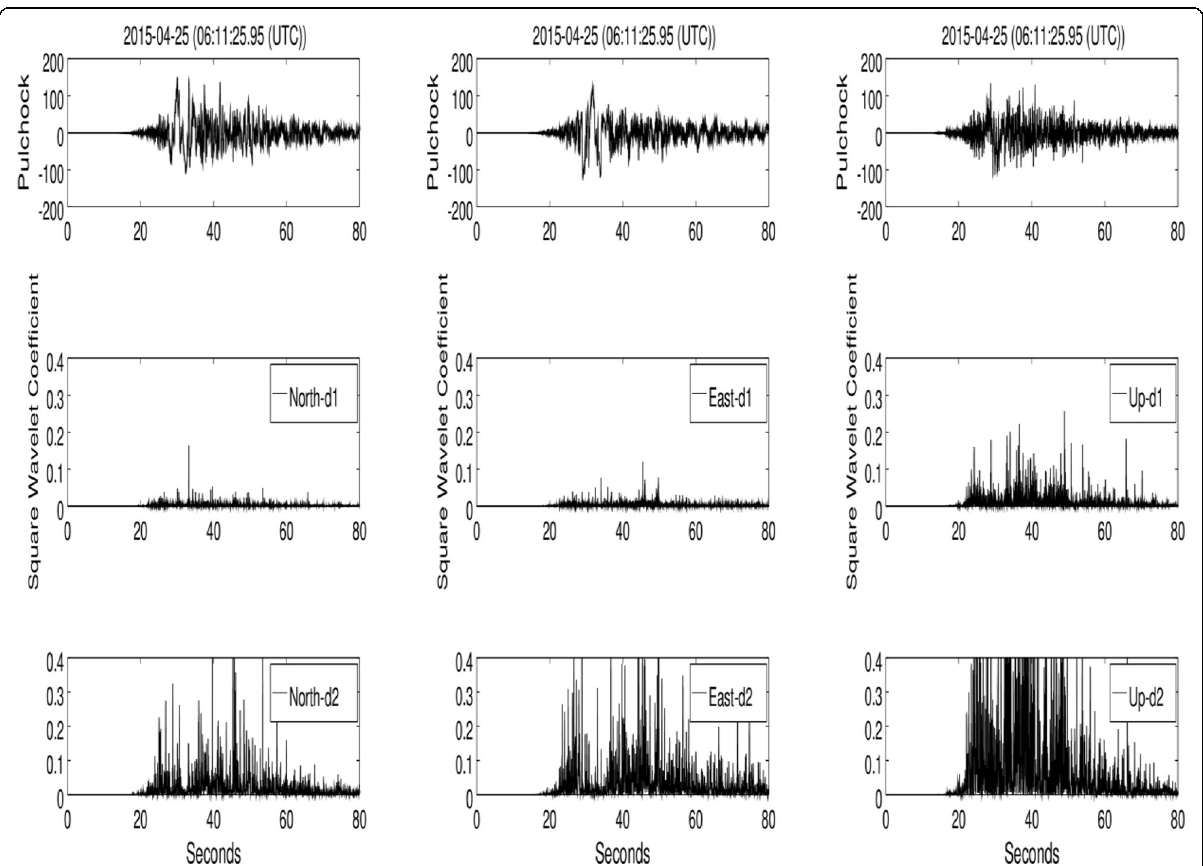
Fig. 15 Square wavelet coefficient dj (j = 1 and 2) of ground motion in NS, EW and Vertical direction observer at PTN